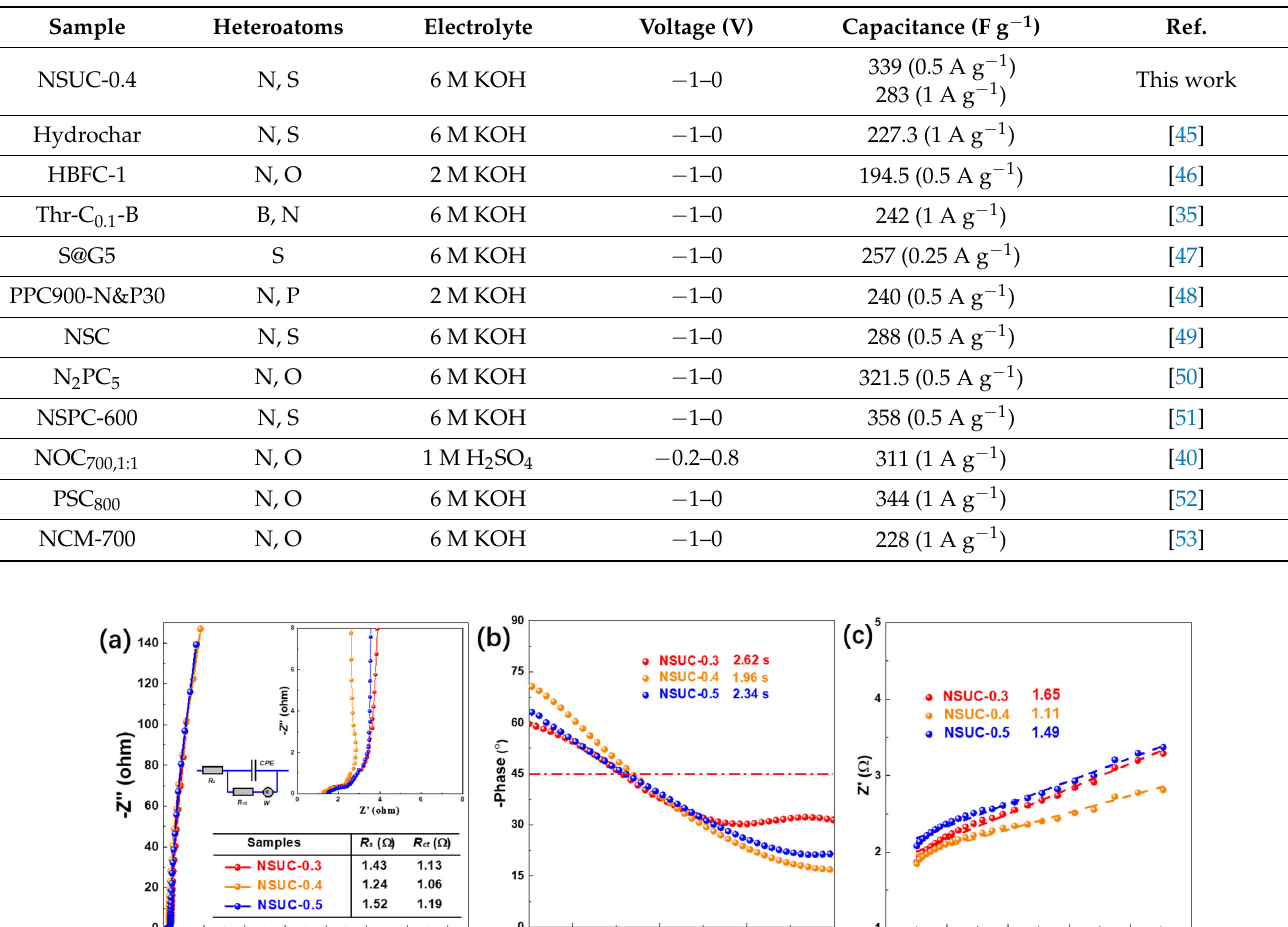
Table 2. Comparison of the electrochemical performances of the reported carbon-based electrodes in three-electrode system.